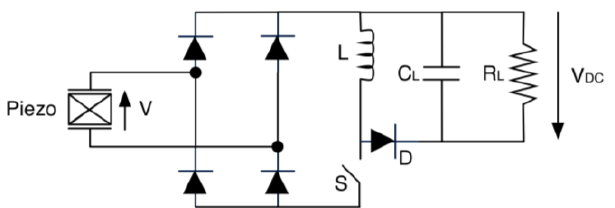
Figure 33. Synchronous charge extraction interface.